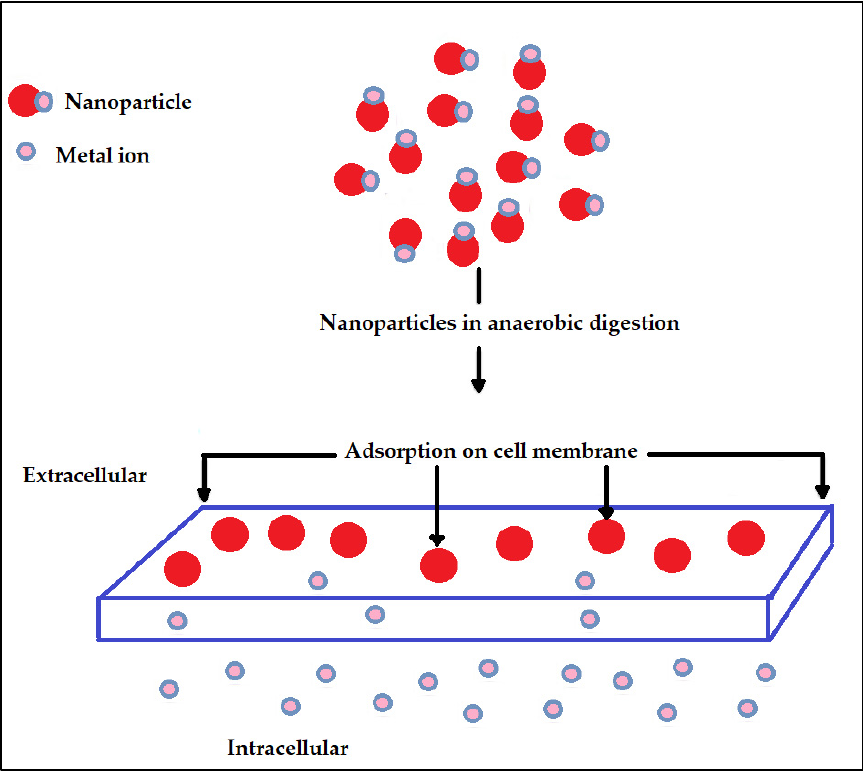
Figure 6. Mechanism of nanoparticles addition in anaerobic digestion